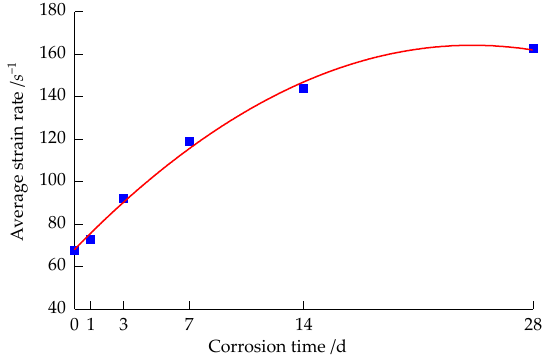
Figure 9. Variation of average strain rate with the solution corrosion time.